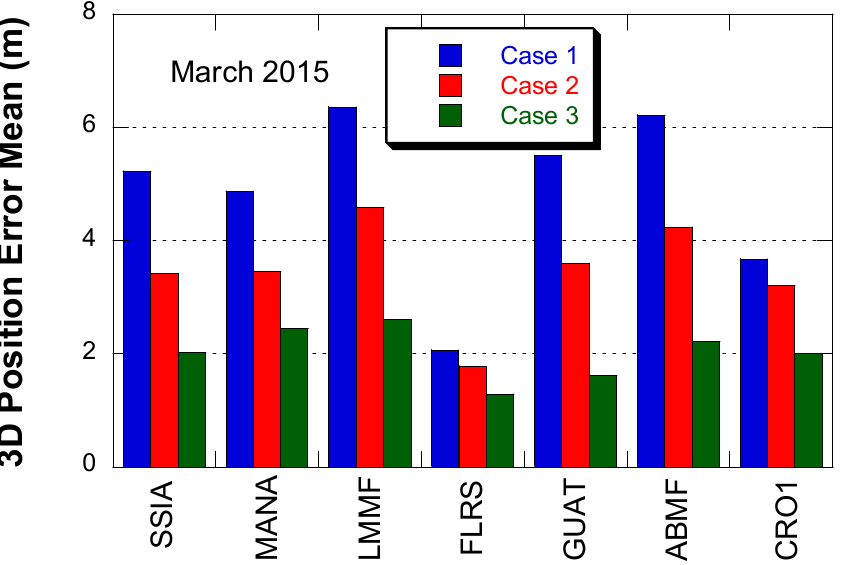
Figure 10. 3D position error mean for different positioning methods at seven IGS stations in March